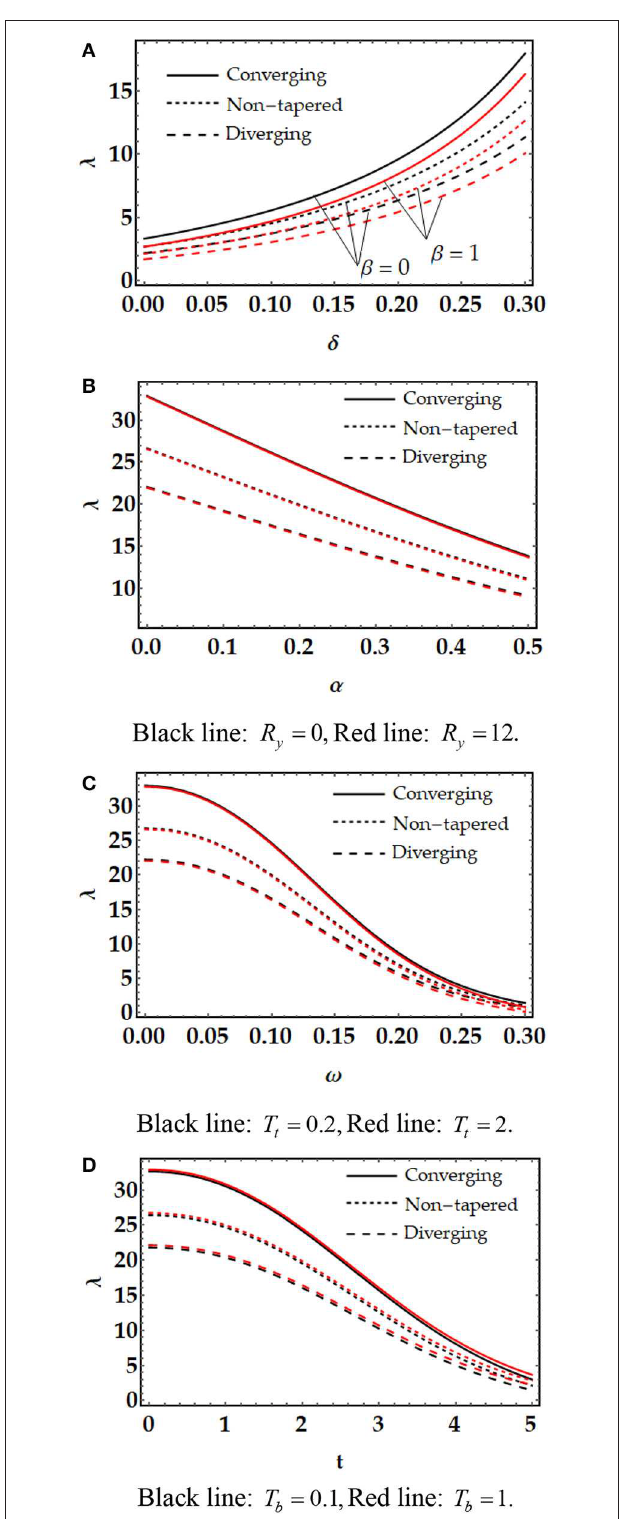
FIGURE 7 | Impedance profile for various values of (A) β ; Black line: β = 0, Red line: β = 1. (B) R y ; Black line: R y = 0, Red line: R y = 12. (C) T t ; Black line: T t = 0.2, Red line: T t = 2. (D) T b ; Black line: T b = 0.1, Red line: T b =